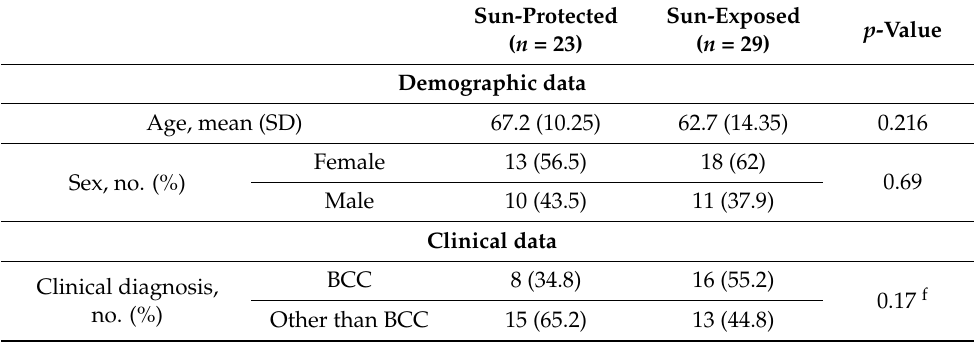
Figure 1. A bar chart demonstrating the anatomical distribution of the total studied cases. Table 1. Demographic and clinic-pathological features.